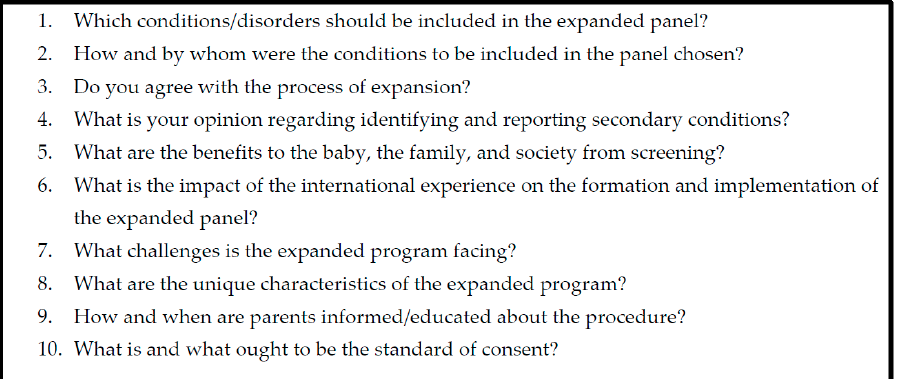
Figure 2. Selected questions from the interview guide.